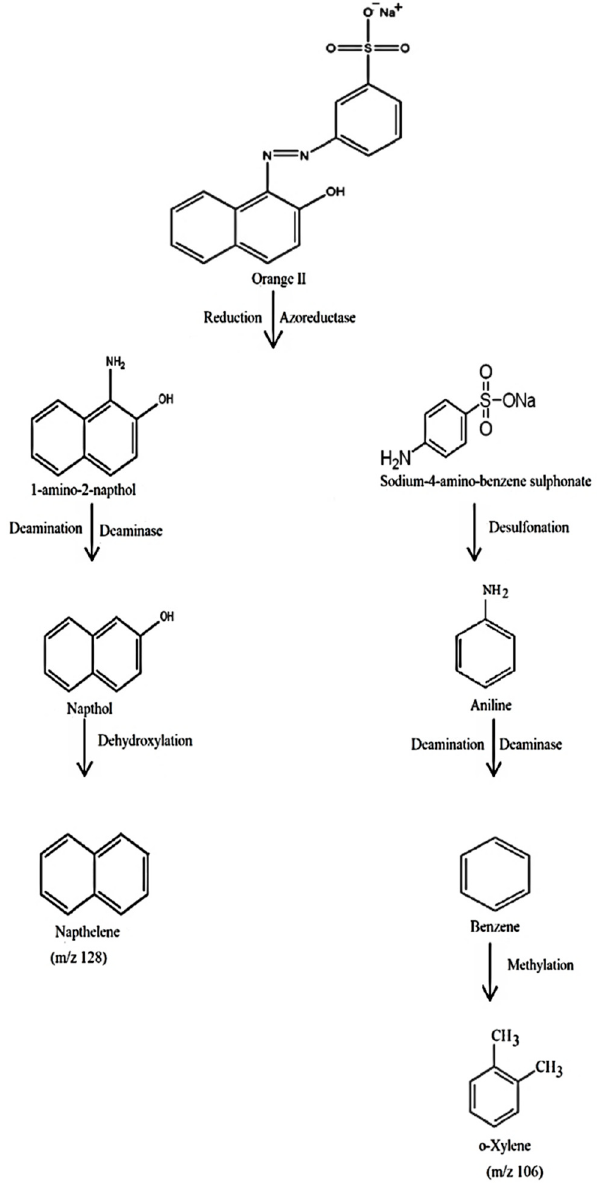
Figure 17. Proposed mechanism for orange II dye degradation by B. subtilis.